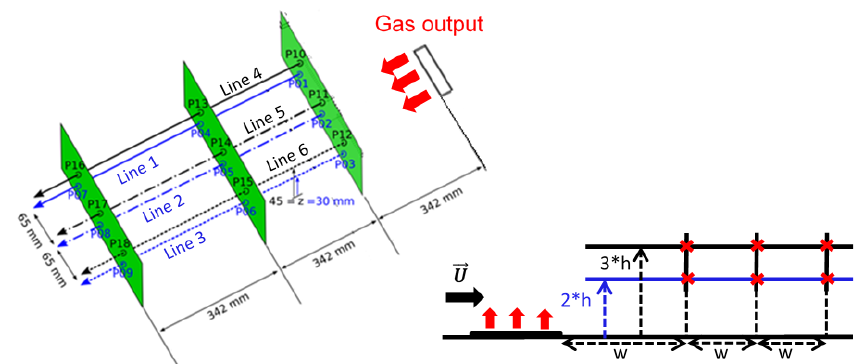
Figure 2. Measurement setup; the pictures are non-dimensional; here, w = 342 mm and h = 15 mm.